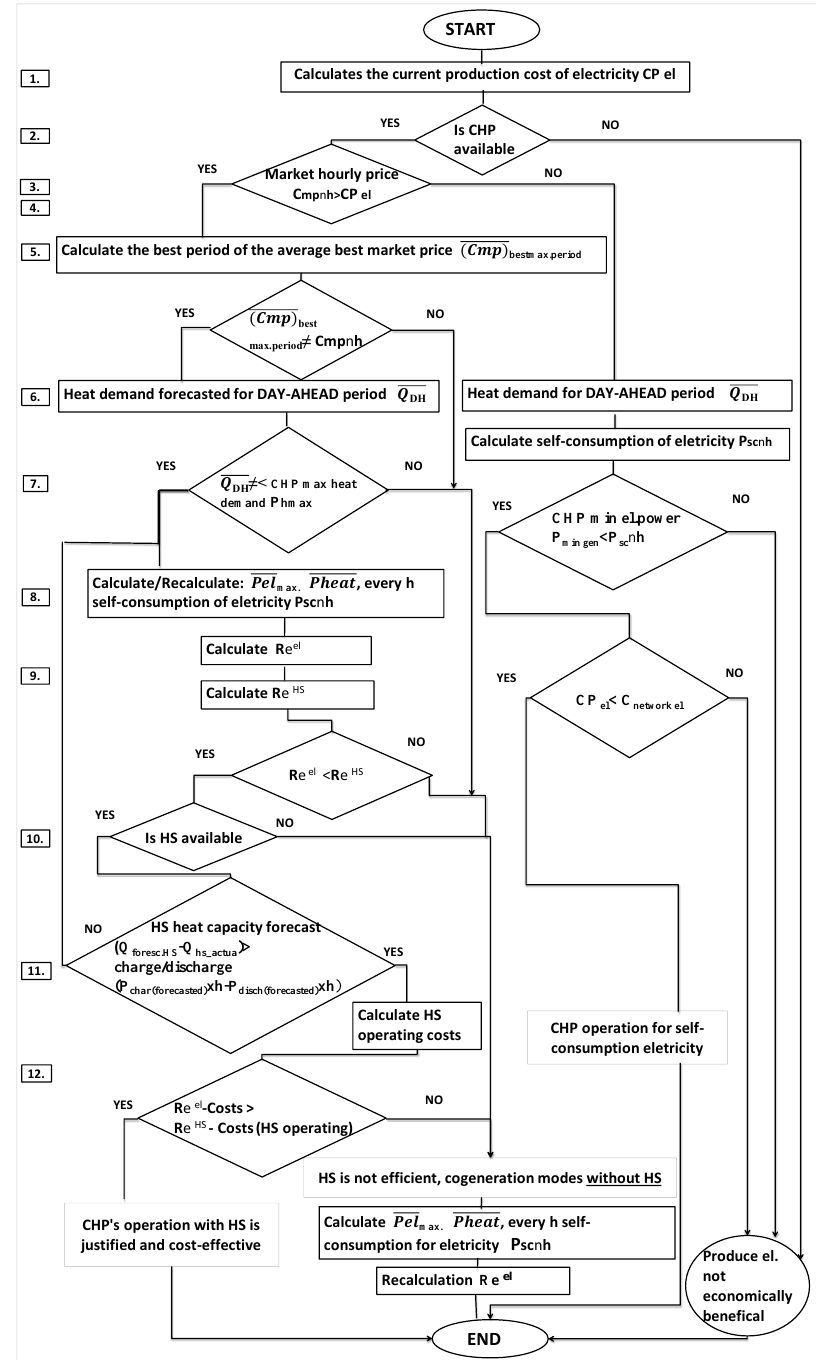
Figure 12. Decision making algorithm block